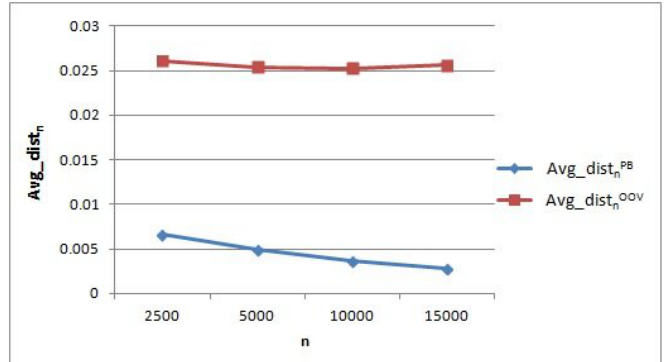
Figure 12. MAE between the experimentally obtained acceptance rates and the OOV and PB points, respectively, for n = 2500, 5000, 10,000 and 15,000.